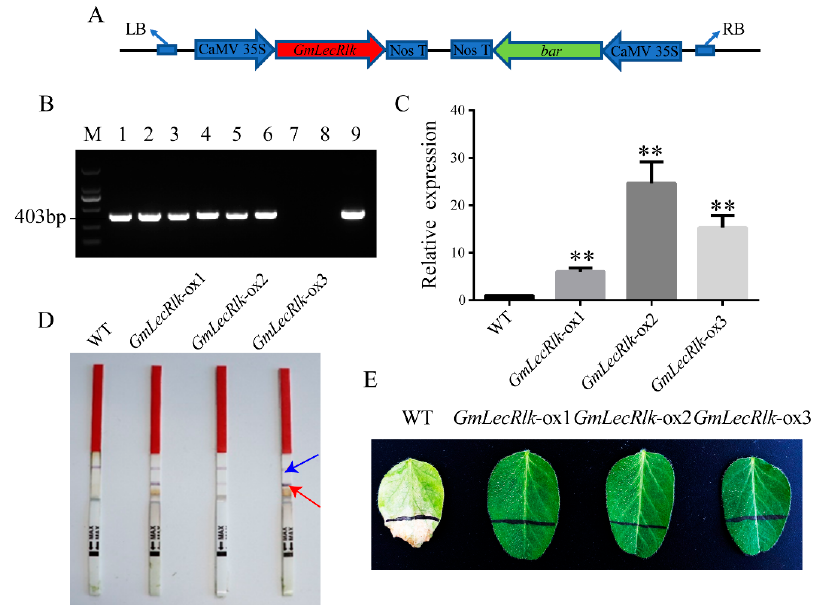
Figure 2. Identification of GmLecRlk -ox transgenic soybean. ( A ) Physical maps of the regions between left border (LB) and right border (RB); ( B ) gel image of PCR products obtained with primer sets for T-DNA regions of the vector. M: DL2000 marker. 1–6: positive plants 7: negative control (ddH2O). 8: DNA of WT soybean plants. 9: plasmid of the pCAMBIA3300 - GmLecRlk vector. ( C ) GmLecRlk gene expression level in transgenic and WT soybean by qRT-PCR. Significant differences were analyzed based on the results of three biological replications (Student’s t test: ** p < 0.01). Bars indicate the standard error of the means (s.e.m). ( D ) Detection of the selectable marker gene bar by test strip. Blue arrow: control. Red arrow: bar is positive. ( E ) GmLecRlk -ox and WT soybean were screened by smearing 180 mg/L PPT on the initial leaves. After salt treatment for 3 days, the results showed that the leaves of the WT were seriously wilted and deformed, while most of the leaves of GmLecRlk-ox had been growing vigorously (Figure 3A). The fresh weight was measured after 3 days under salt stress, and the results showed that the fresh weight of GmLecRlk-ox was significantly higher than that of the WT (Figure 3B). The ratio of variable to maximal fluorescence (Fv/Fm) is an im- portant parameter that reflects the photosynthetic status of plants under stress. Stress damages photosystem II and reduces the efficiency of Fv/Fm [19]. The Fv/Fm value of the GmLecRlk-ox transgenic soybean was significantly higher than that of the WT soybean af- ter 2 days of salt stress (Figure 3C). The contents of Pro and MDA were further measured, and the results showed that the Pro content of GmLecRlk-ox plants was significantly higher than that of the WT, while the content of MDA was lower than that of WT plants (Figure 3D,E).